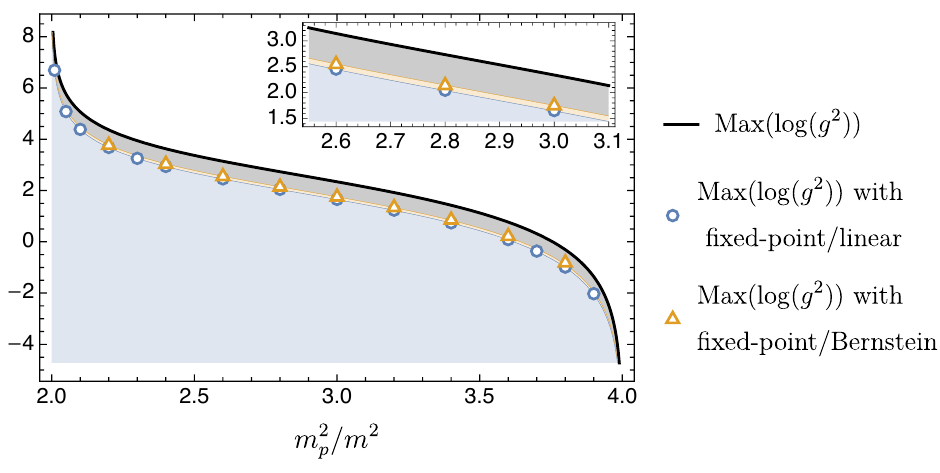
Figure 6 . Convergence of the fixed point iteration occurs in the blue-shaded and yellow-shaded regions, depending on the interpolation